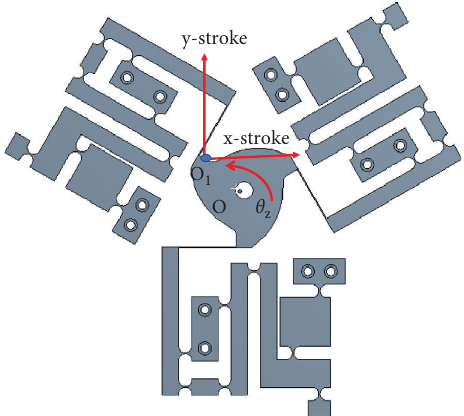
Figure 17: Measurement of rotation angle of the microrobotic